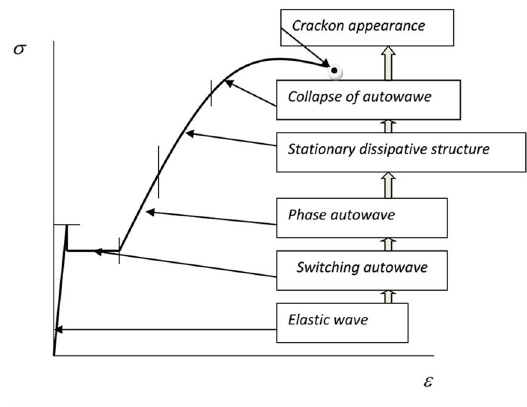
Figure 5. Wave and autowave processes involved in